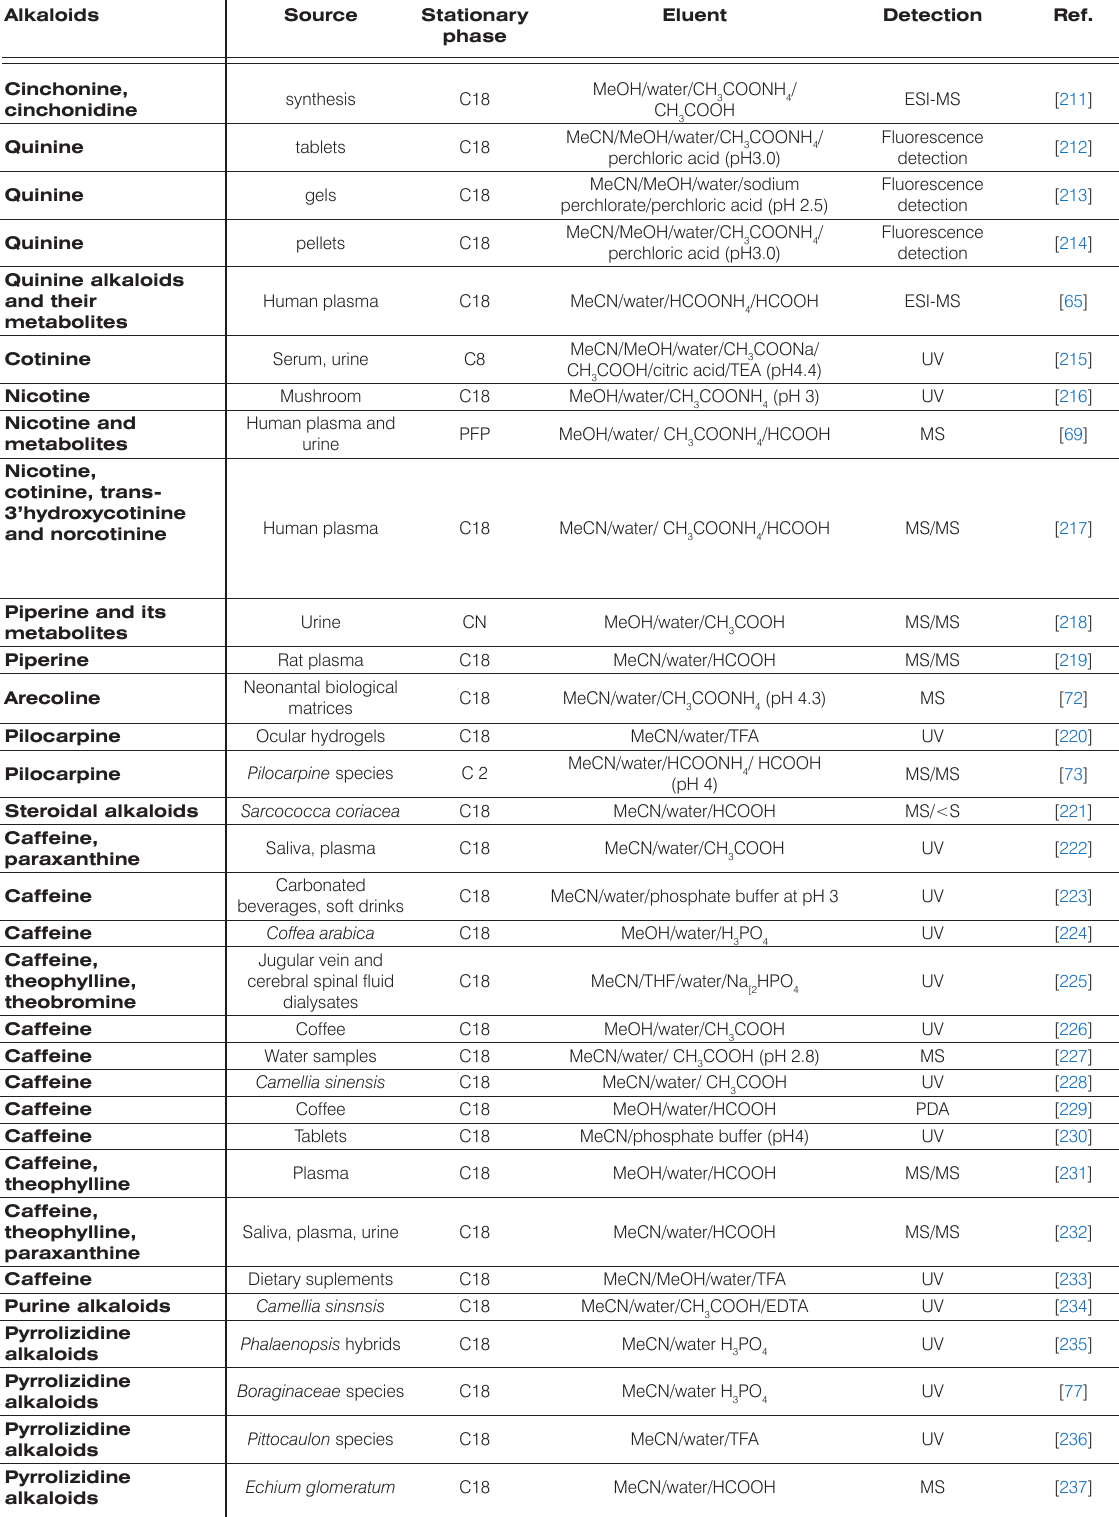
Table 2. Methods used for HPLC of alkaloids with mobile phase at acidic